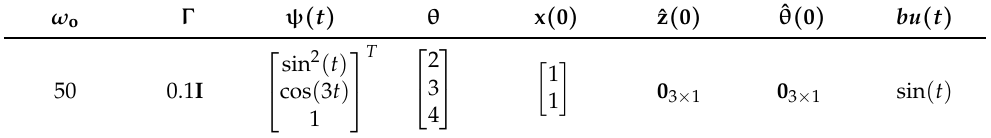
Table 2. Parameters of the simulation of PIESO with time-dependent regressor.